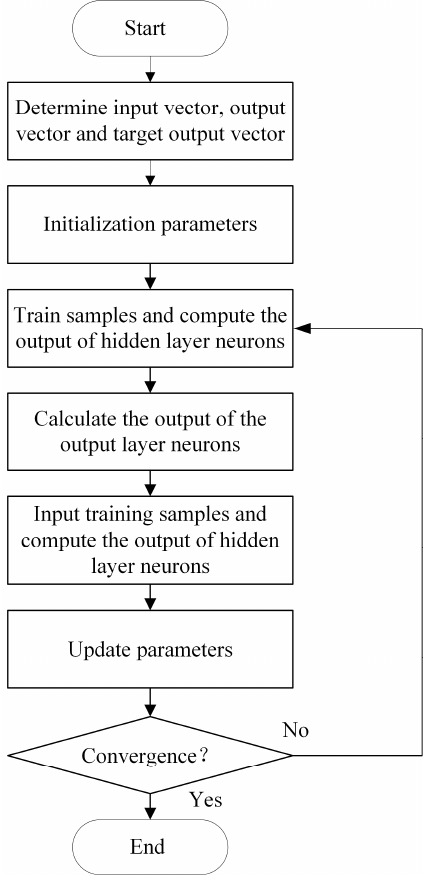
Figure 7. RBF aerodynamic modeling scheme.